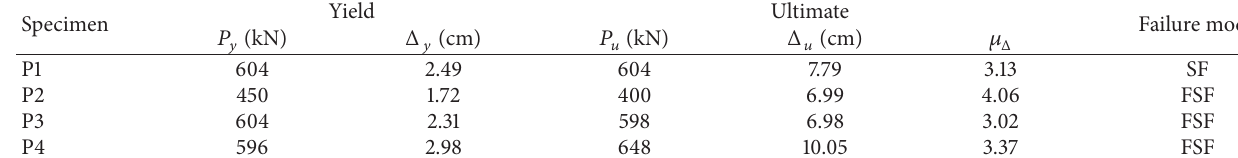
Table 3: Test results: strength, top lateral displacements, and ductility.